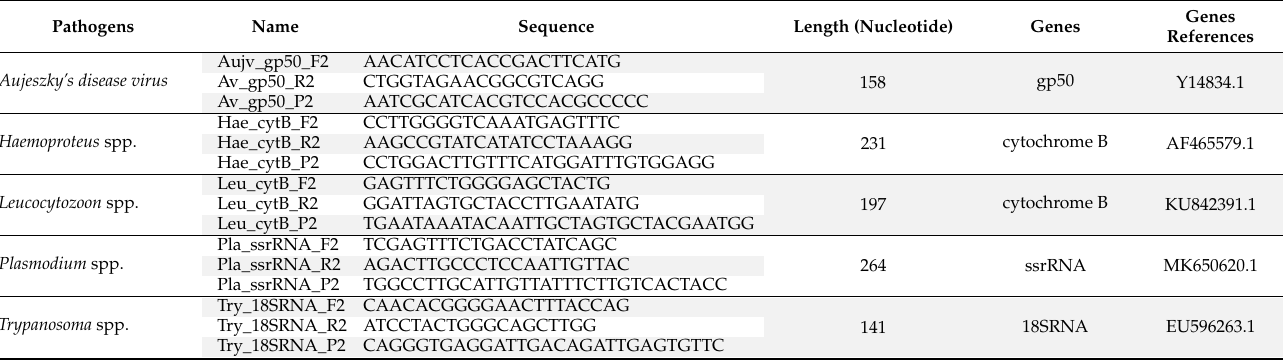
Table 2. List of pathogens, targets, and primer/probe sets used for species confirmation using real-time